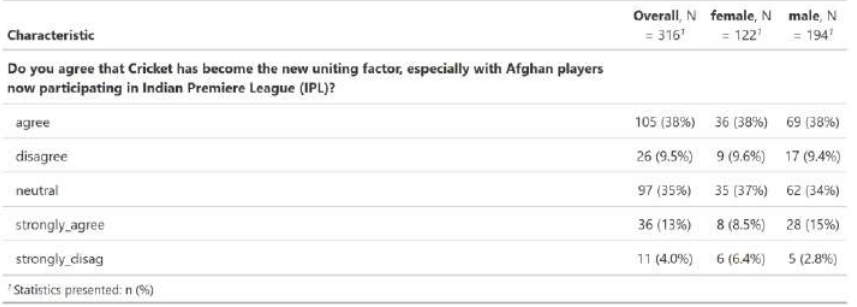
Table 27: Besides films, serials, cricket, scholarships, and aid, what other things unite Afghans and India? (Source: Authors‟ depiction )